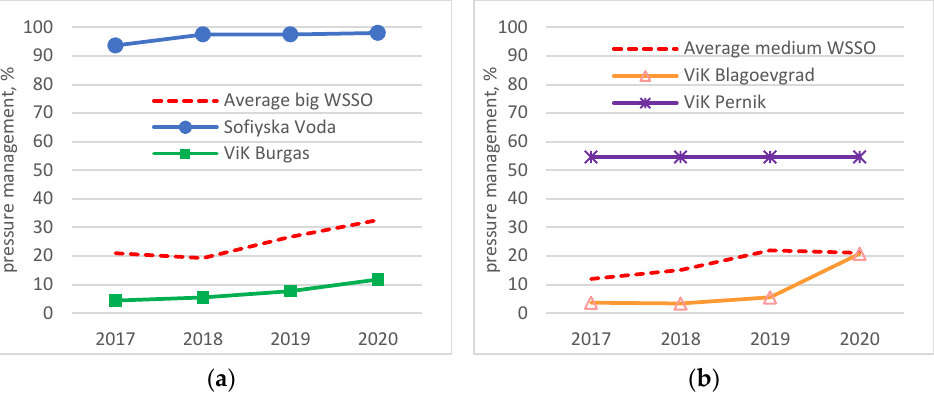
Figure 5 . Trends in the rate of implementation of pressure management for ( a ) Sofiyska Voda and ViK Burgas, and ( b ) ViK Blagoevgrad and ViK Pernik .